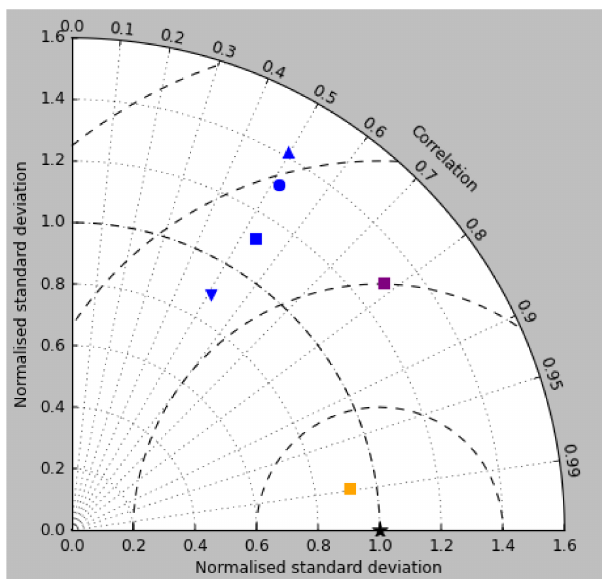
Figure 18. Taylor diagram for surface DIC (orange), surface total alkalinity (purple) and surface p CO 2 (blue). Model DIC and total alkalinity from the RCP8.5 simulation (meaned over the years 2010 to 2019) are compared to the gridded fields from GLODAPv2, while model p CO 2 (meaned over 1990 to 2009) is compared to the Taka- hashi gridded data. Filled squares refer to the raw surface fields, and filled circles, upward-pointing triangles and downward trian- gles respectively refer to the midpoint, amplitude and phase of the sine curve that best fits the seasonal cycle (in points for which the variance of the residual is less than half that of the original cycle).